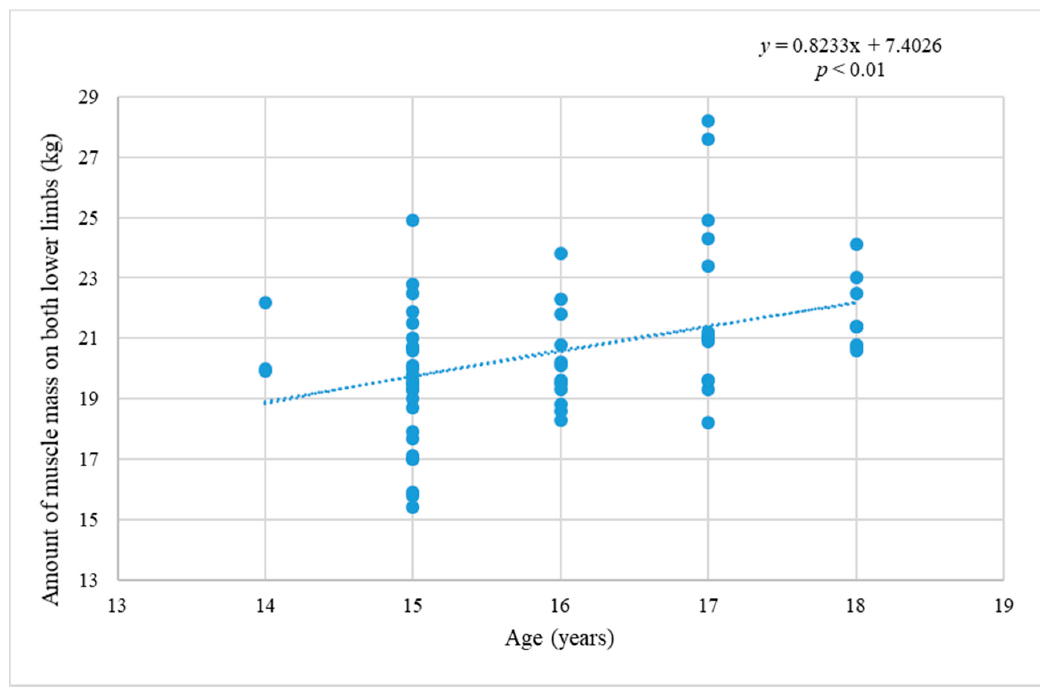
Figure 6. The relationship between the amount of MM in the both legs and age. The right leg was completely dominant in all monitored parameters in more than one-third of players. The distribution of the monitored variances was similar when the players were distributed